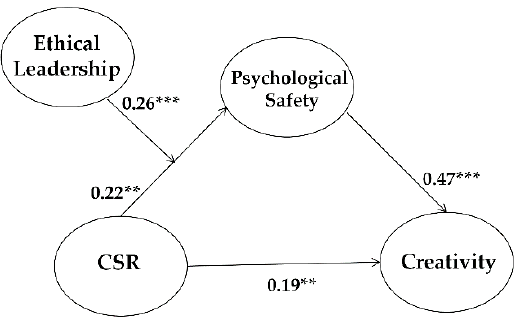
Figure 3. Final structural model. Standardized coefficients are presented. ** p < 0.01, *** p < 0.001. Table 4. Direct, indirect, and total effects of the final research model. Model